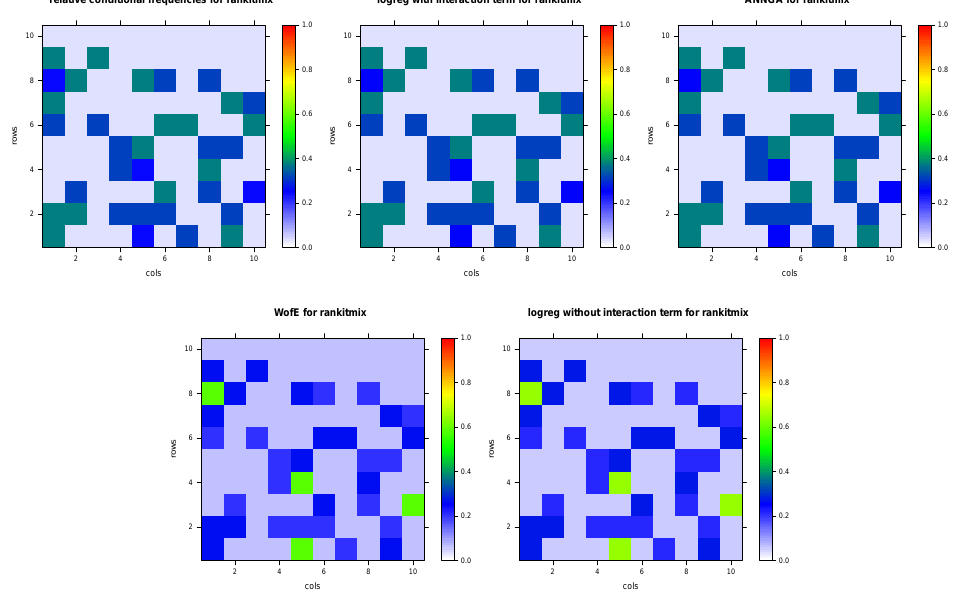
Figure 3. Spatial distribution of predicted conditional probabilities (cid:98) P ( T = 1 | B the training dataset RANKITMIX according to: elementary estimation ( top left ); logistic regression with interaction term ( top center ); artificial neural net ANNGA of R ( top right ); weights-of-evidence ( bottom left ); logistic regression without interaction ( bottom right